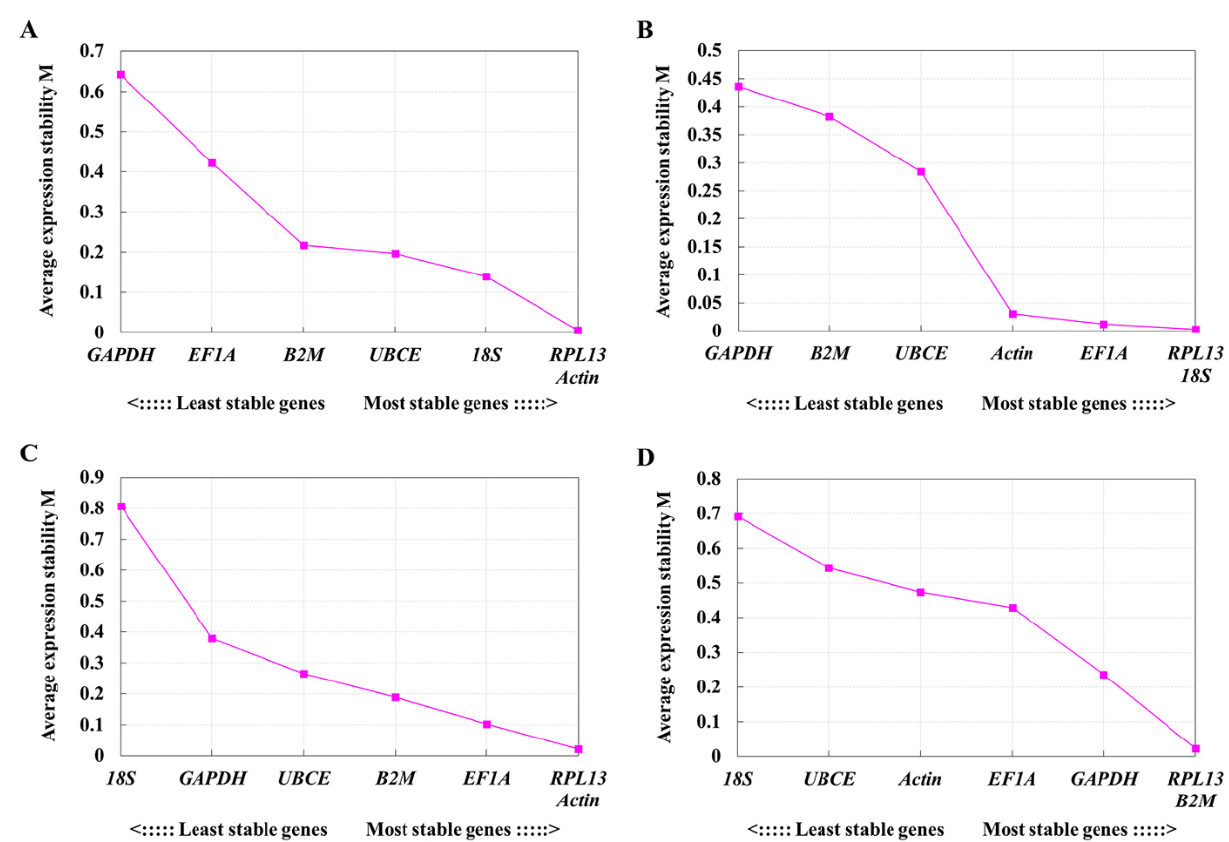
Figure 3. The expression stability of housekeeping gene candidates in GPS cells under stimulation with LPS for 2 ( A ), 4 ( B ), 8 ( C ) and 12 h ( D ) assessed by geNorm. According to the C t values presented by seven housekeeping gene candidate stimulations with LPS or PBS, the average expression stability of housekeeping gene candidates can be evaluated as M by geNorm; not only can the M value not be more than 1.5, but the most reliable housekeeping genes have the most minimal M value as